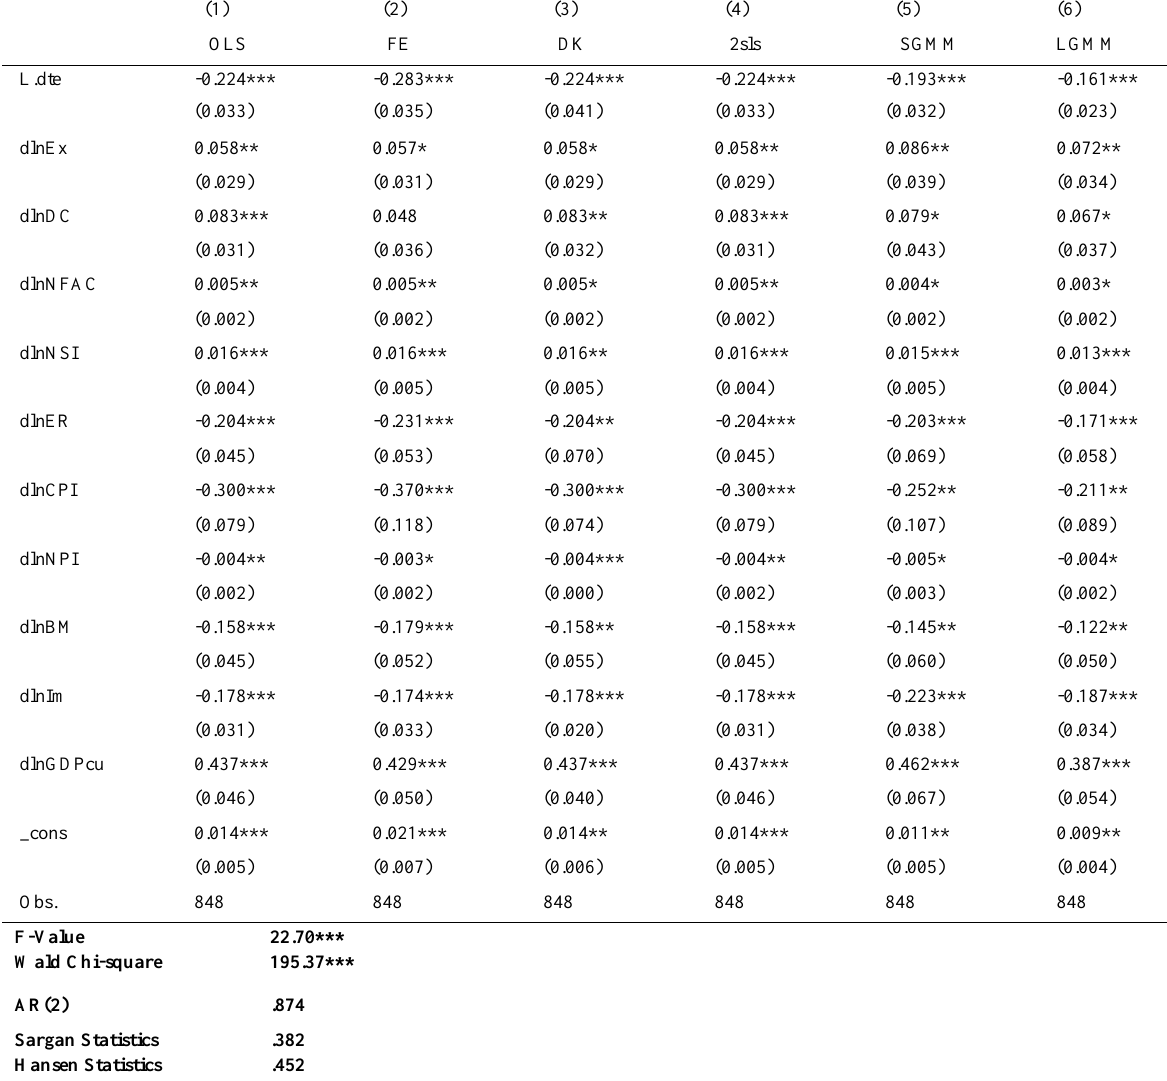
Table 12: Determinants of wealth maximizing technical efficiency with NFA